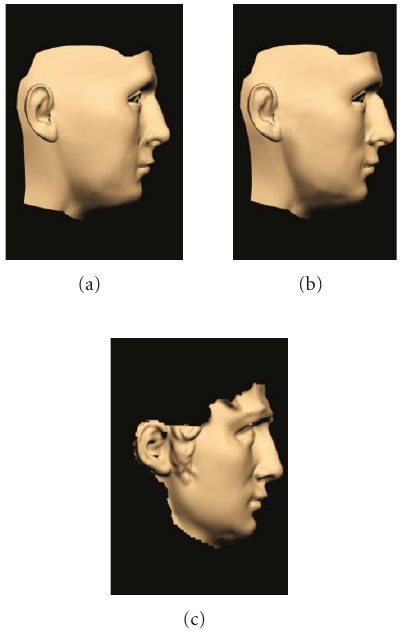
Figure 7: Side view comparison of adaption results between com- bination approach and RBF approach. (a) RBF approach; (b) com- bination approach; (c) scanned